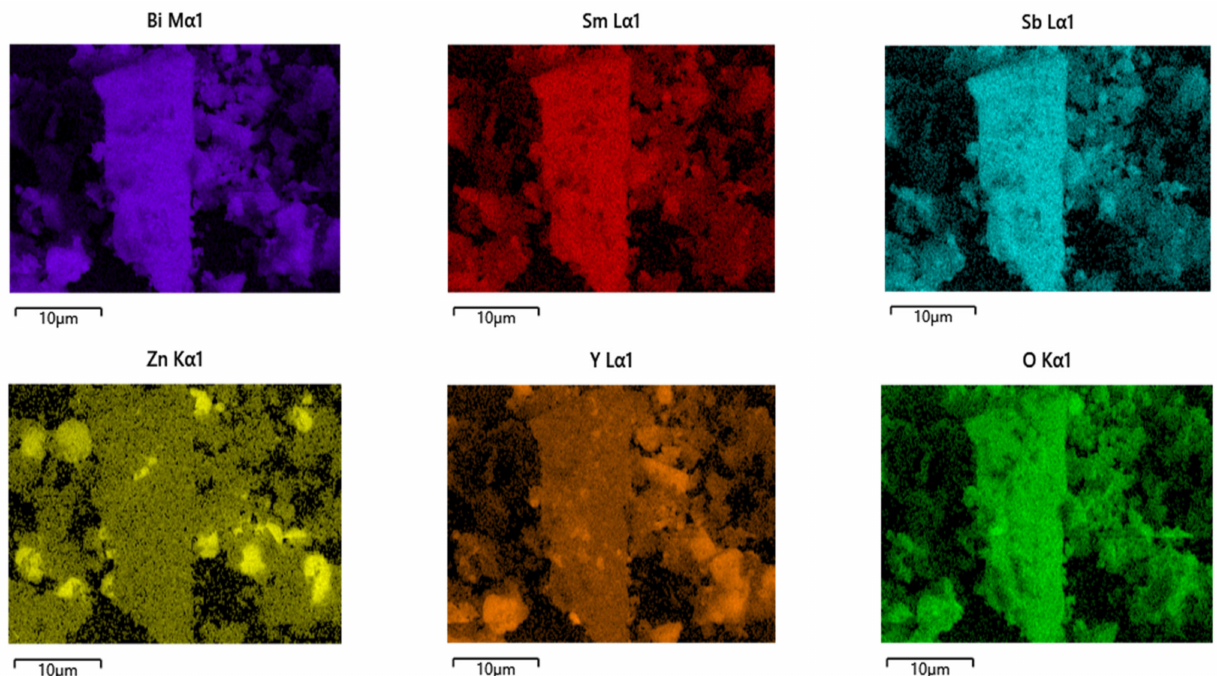
Figure 10. EDS elementary mapping of Bi 2 SmSbO 7 /ZnBiYO 4 heterojunction catalyst (Bi, Sm, Sb, O from Bi 2 SmSbO 7 and Zn, Bi, Y, O from ZnBiYO 4 ).